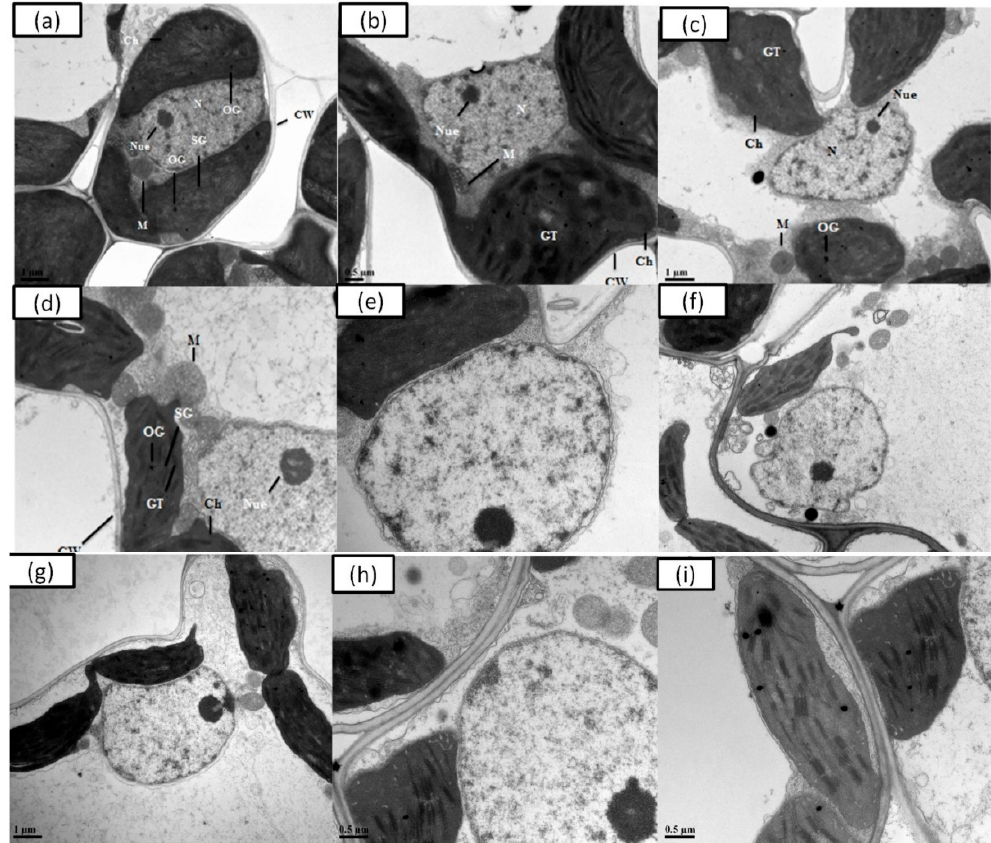
Figure 5. Electron micrographs of leaf mesophyll cells of two various rice cultivars (CY-927, YLY-689) primed with water as well as primed with 0.01 µ M EBL grow under control and exposure of 100 µ M Cr stress. ( a ) Leaf mesophyll cell of CY-927 (primed with water) at the control level. ( b ) Leaf mesophyll cell of CY-927 (primed with 0.01 µ M EBL) at the control level. ( c ) Leaf mesophyll cell of YLY-689 (primed with water) at the control level. ( d ) Leaf mesophyll cell of YLY-689 (primed with 0.01 µ M EBL) at the control level. ( e ) Leaf mesophyll cell of CY-927 (primed with water) underexposure of 100 µ M Cr toxicity. ( f ) Leaf mesophyll cell of CY-927 (primed with 0.01 µ M EBL) under 100 µ M Cr toxicity. ( g ) Leaf mesophyll cell of YLY-689 (primed with water) under the disclosure of 100 µ M Cr stress. ( h , i ) Leaf mesophyll cell of YLY-689 (primed with 0.01 µ M EBL) under 100 µ M Cr toxicity, N (nucleus); CW (cell wall); Ch (chloroplast); GT (granule thylakoids); M (mitochondria); Nue (nucleolus); NM (nuclear membrane).